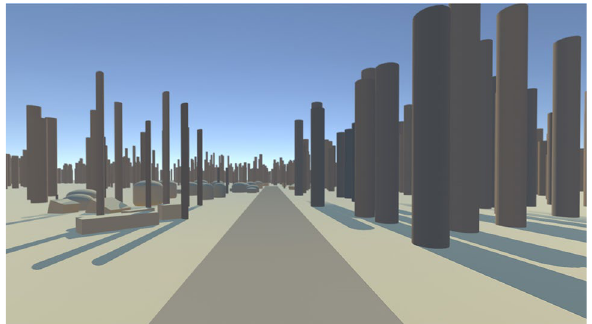
Figure 2. Control